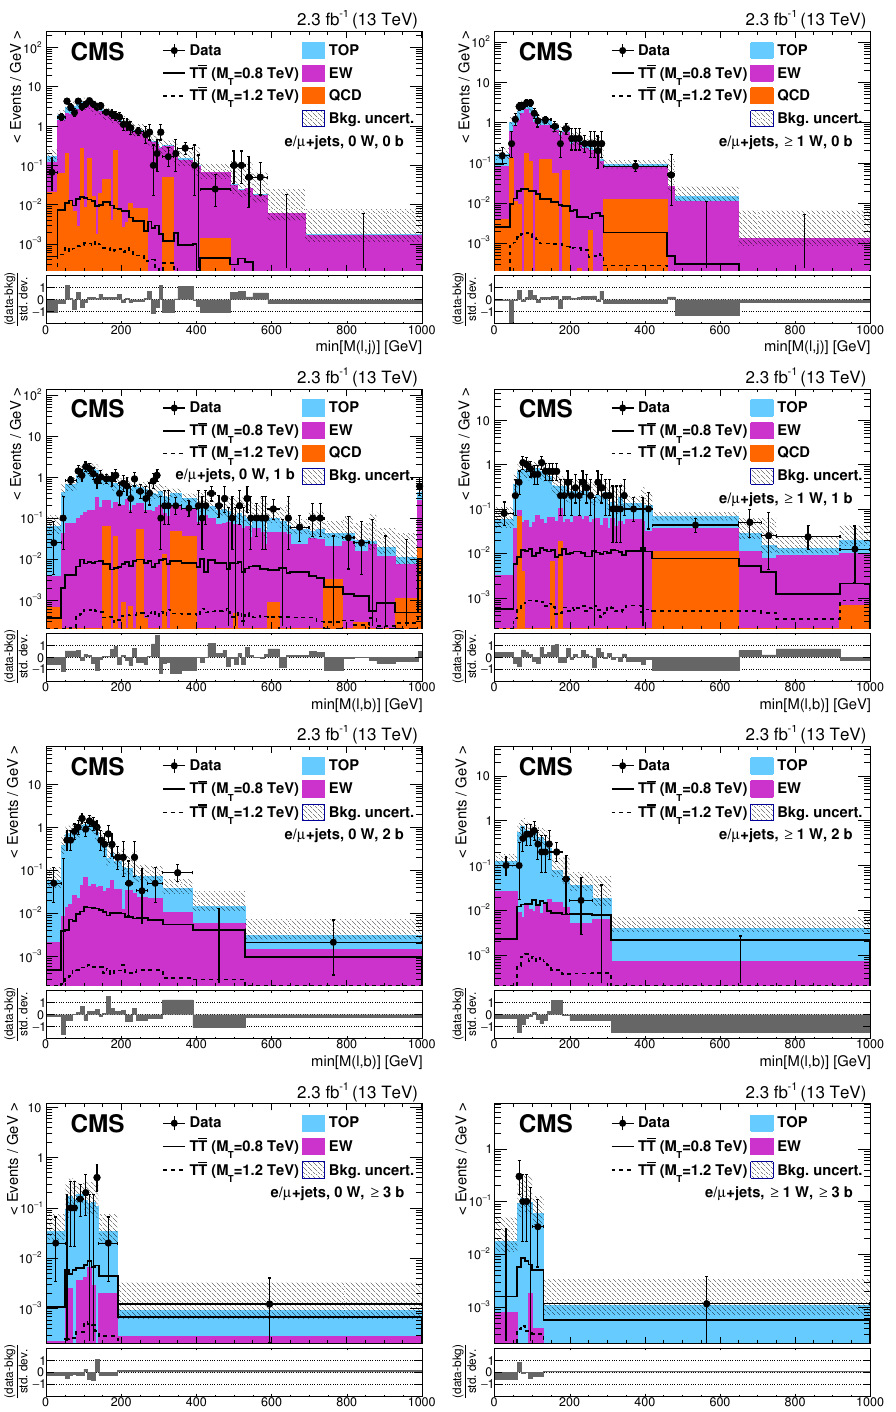
Figure 9 . Distributions of min[ M ( ‘; j )] or min[ M ( ‘; b)] in the combination of electron and muon channels in the boosted W categories with 0 (left) or (cid:21) 1 (right) W-tagged jets and (upper to lower) 0, 1, 2, or (cid:21) 3 b-tagged jets. Also shown are the distributions of TT signal events with T quark masses of 0.8 and 1.2 TeV. The uncertainty in the background includes the statistical and systematic uncertainties described in section